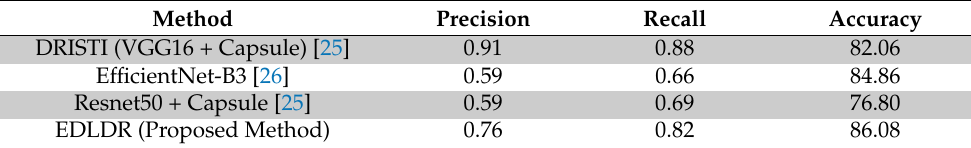
Table 7. Results comparison, five